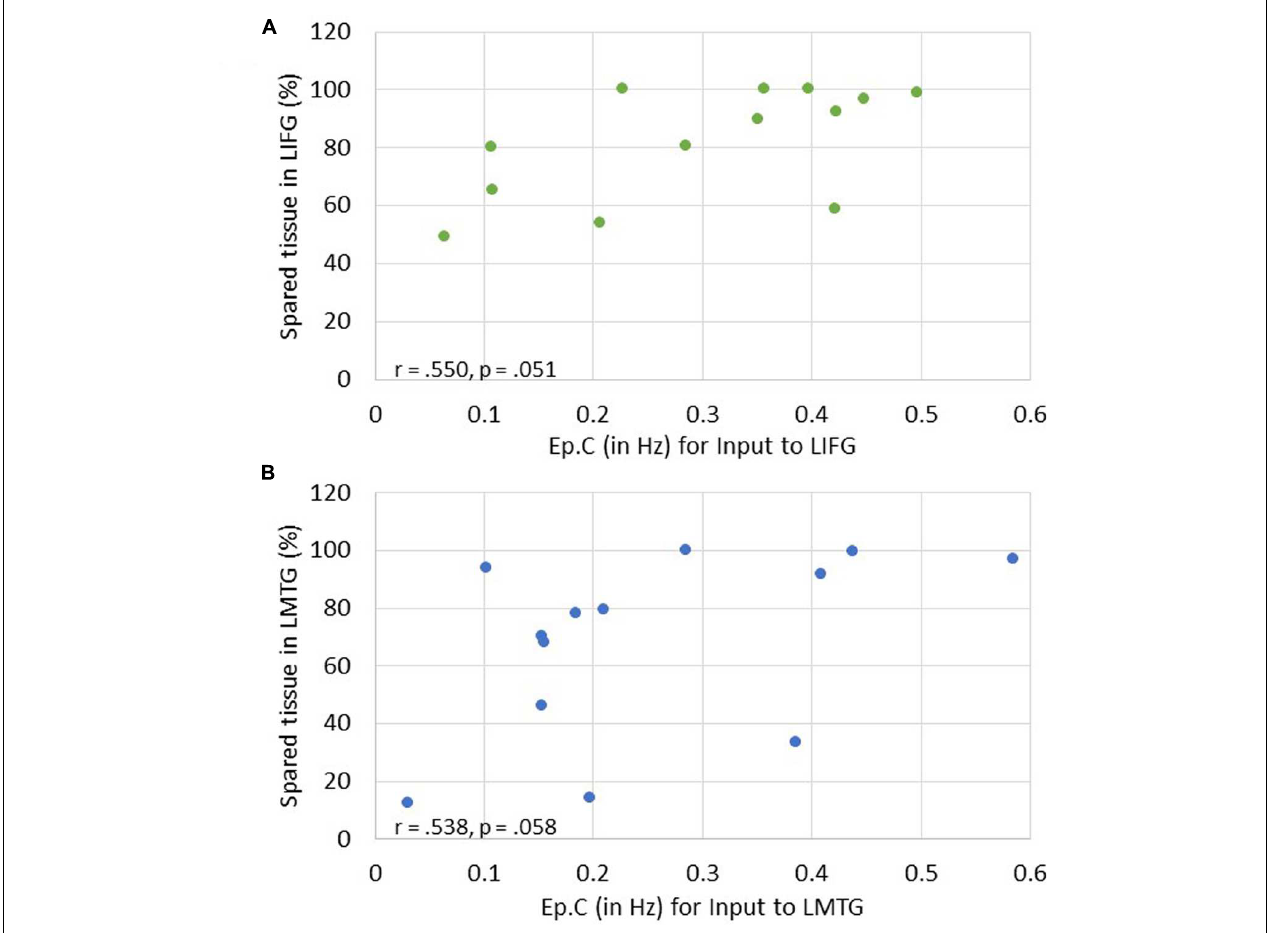
FIGURE 8 | Correlations between percentage of spared tissue and strength of task-induced perturbation to specific regions (i.e., Ep.C values in Hz). (A) For family #1, an association that approached significance was found between strength of driving input of LIFG and amount of spared tissue in LIFG. (B) For family #3, a trending association between driving input strength of LMTG and the amount of spared tissue in